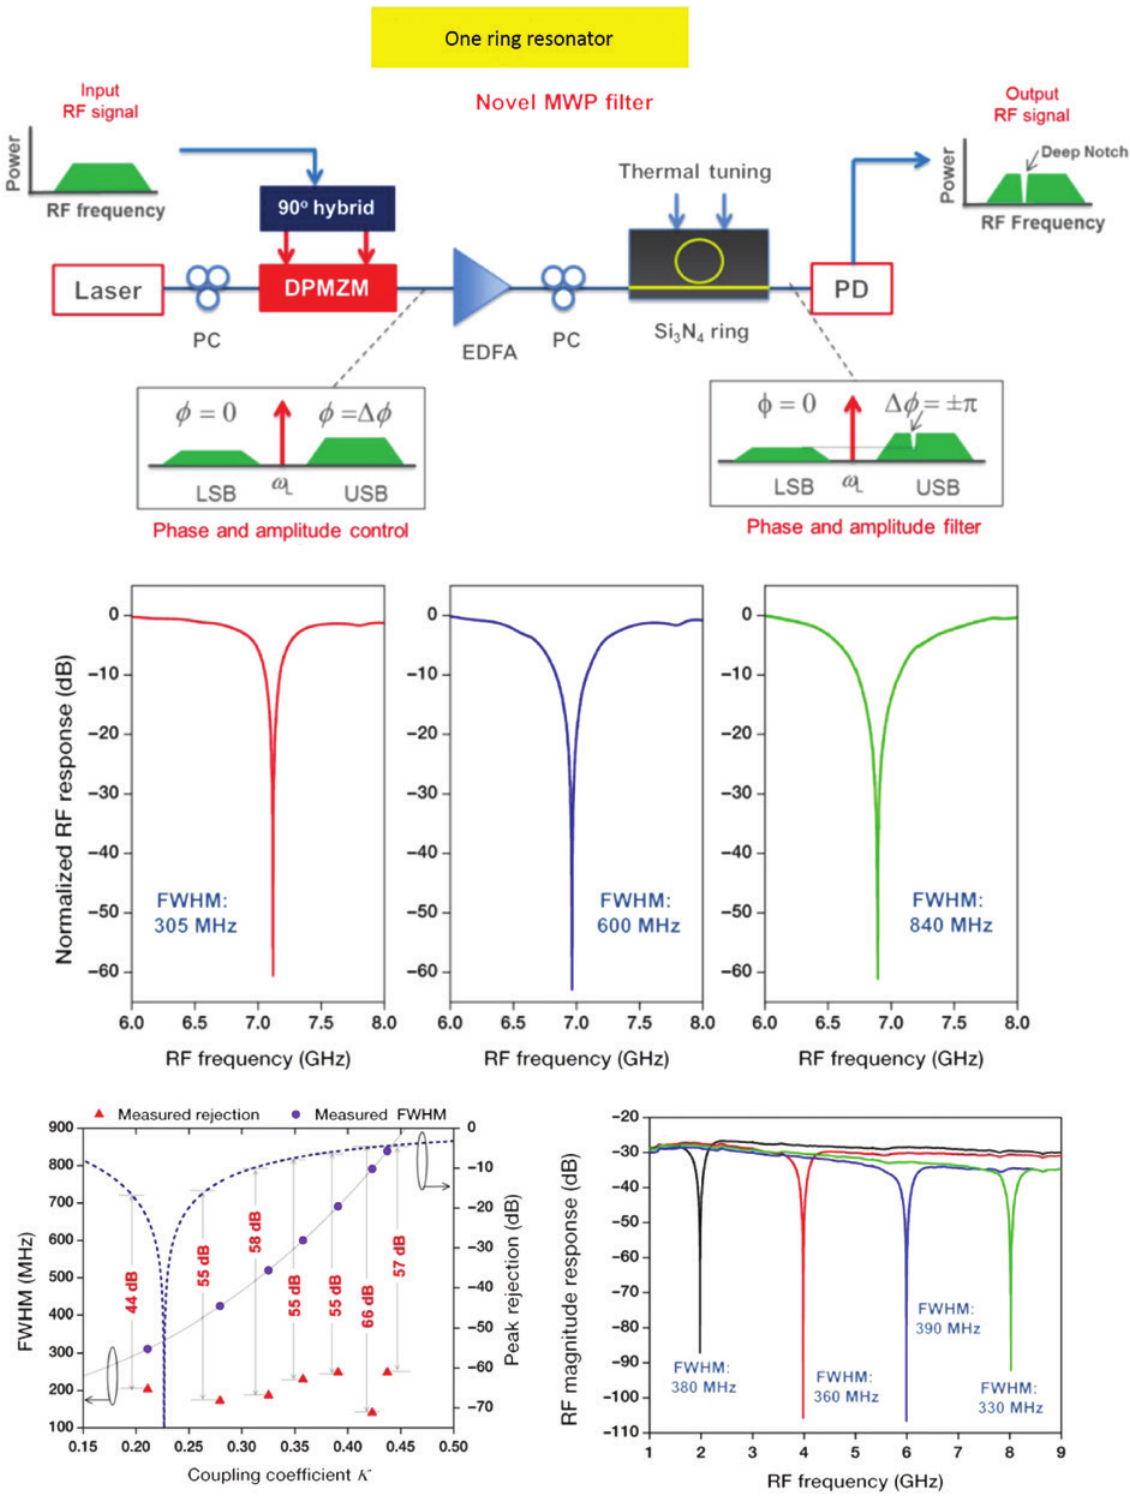
Figure 6: Microwave photonics implementations of RF filters using optical signal processor chips that comprise one ring resonators, showing the evolution toward DSP flexibility [61] (Copyright in 2013, Optical Society of